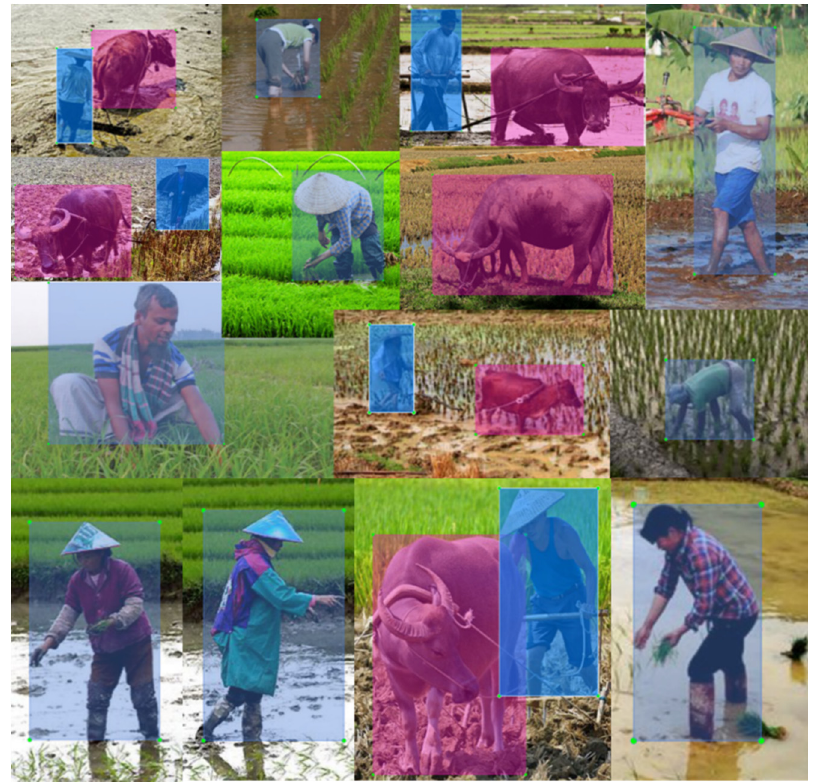
Figure 2. Parts of labeled images in dataset. The pink and blue rectangles are self-labeled ground truths. The pink rectangles are ground truths for water buffaloes, the blue ones are for humans.